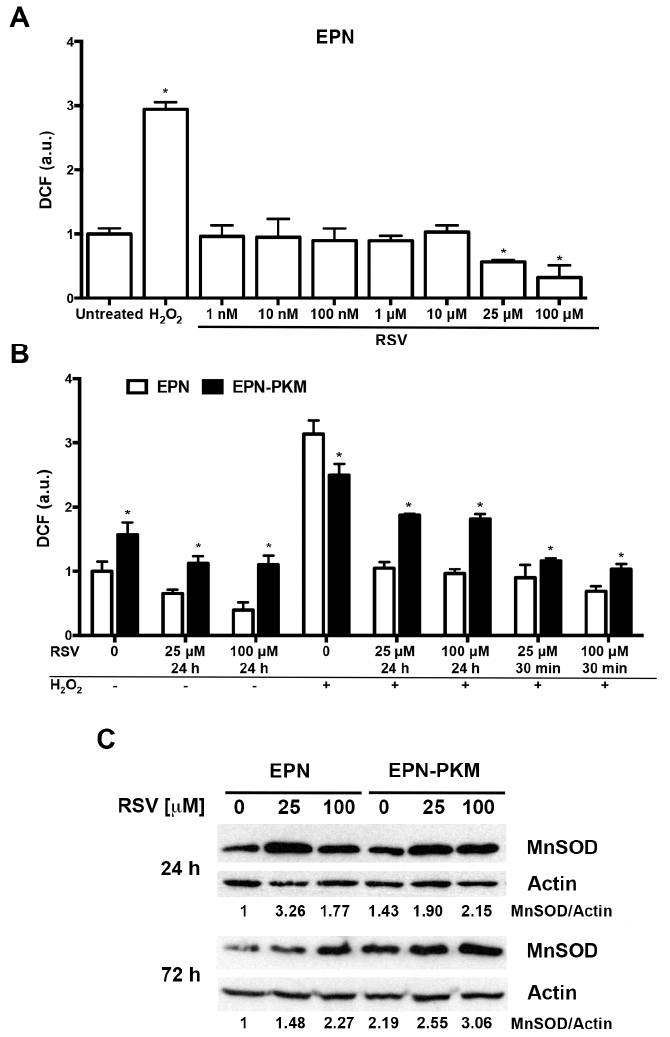
Figure 2. Effects of PYK2 mutation and RSV on ROS production and MnSOD expression in EPN and EPN-PKM cells: ( A ) ROS levels were estimated indirectly by measuring the fluorescence emitted by dichlorofluoresceine (DCF) 30 min after addition of RSV (1 nM to 100 µ M) or 400 µ M H 2 O 2 to EPN cells. Data are mean ± SD of a representative experiment performed in triplicate. (*) indicates statistically significant differences ( p < 0.05) between treated and untreated EPN cells; ( B ) EPN and EPN-PKM cells were either pretreated for 24 h with RSV (25 and 100 μ M) prior to the addition of 400 μ M H 2 O 2 , or treated concomitantly with RSV (25 and 100 μ M) and 400 μ M H 2 O 2 . The levels of ROS were estimated indirectly by measuring the fluorescence emitted by DCF 30 min after addition of H 2 O 2 . Data are mean ± SD of a representative experiment performed in triplicate. (*) indicates statistically significant differences ( p < 0.05) between EPN and EPN-PKM cells at each experimental point; ( C ) Western blot analysis of MnSOD protein expression in EPN and EPN-PKM cells in control conditions and treated with 25 and 100 μ M RSV for 24 or 72 h. β -Actin was used as loading control. The relative optical density of MnSOD levels normalized to β -Actin levels is shown.